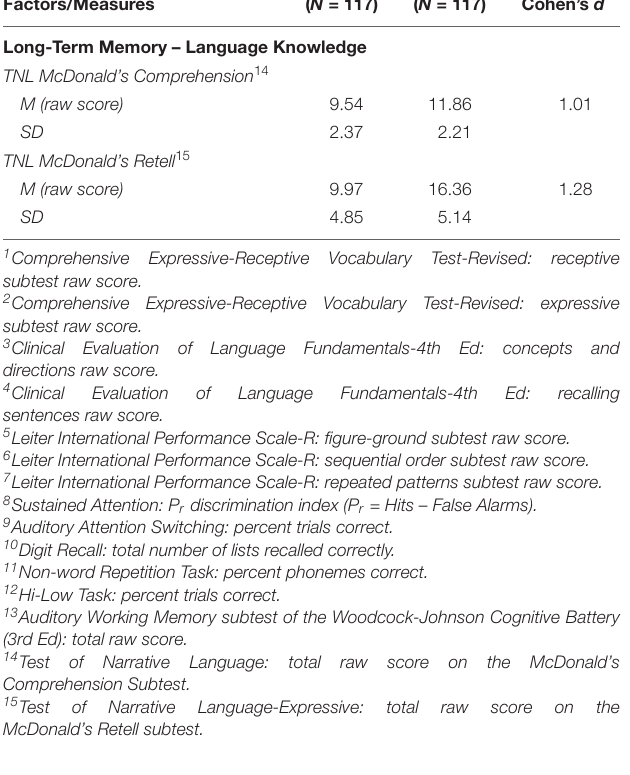
Fluid Reasoning Three non-verbal measures were used to form the latent variable representing fluid reasoning. The primary executive abilities of interest were the ability to recognize patterns, to reason, and to solve novel problems independent of prior knowledge. Figure-Ground (Leiter-FG) The figure-ground subtest of the Leiter-R (Roid and Miller, 1997) served as an index of children’s ability to recognize and use holistic patterns in the service of solving a visual problem that involved identifying figures or designs that were embedded within complex stimuli. The dependent variable was the total number of items correct. Internal consistency reliability, as reported in the manual, varied from 0.74 to 0.80 across the ages of the children in this study.